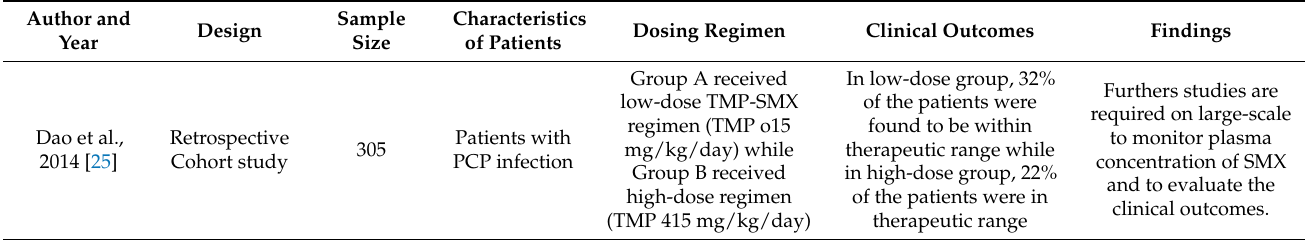
Table 1. Dosing strategy of TMP-SMX in included studies.